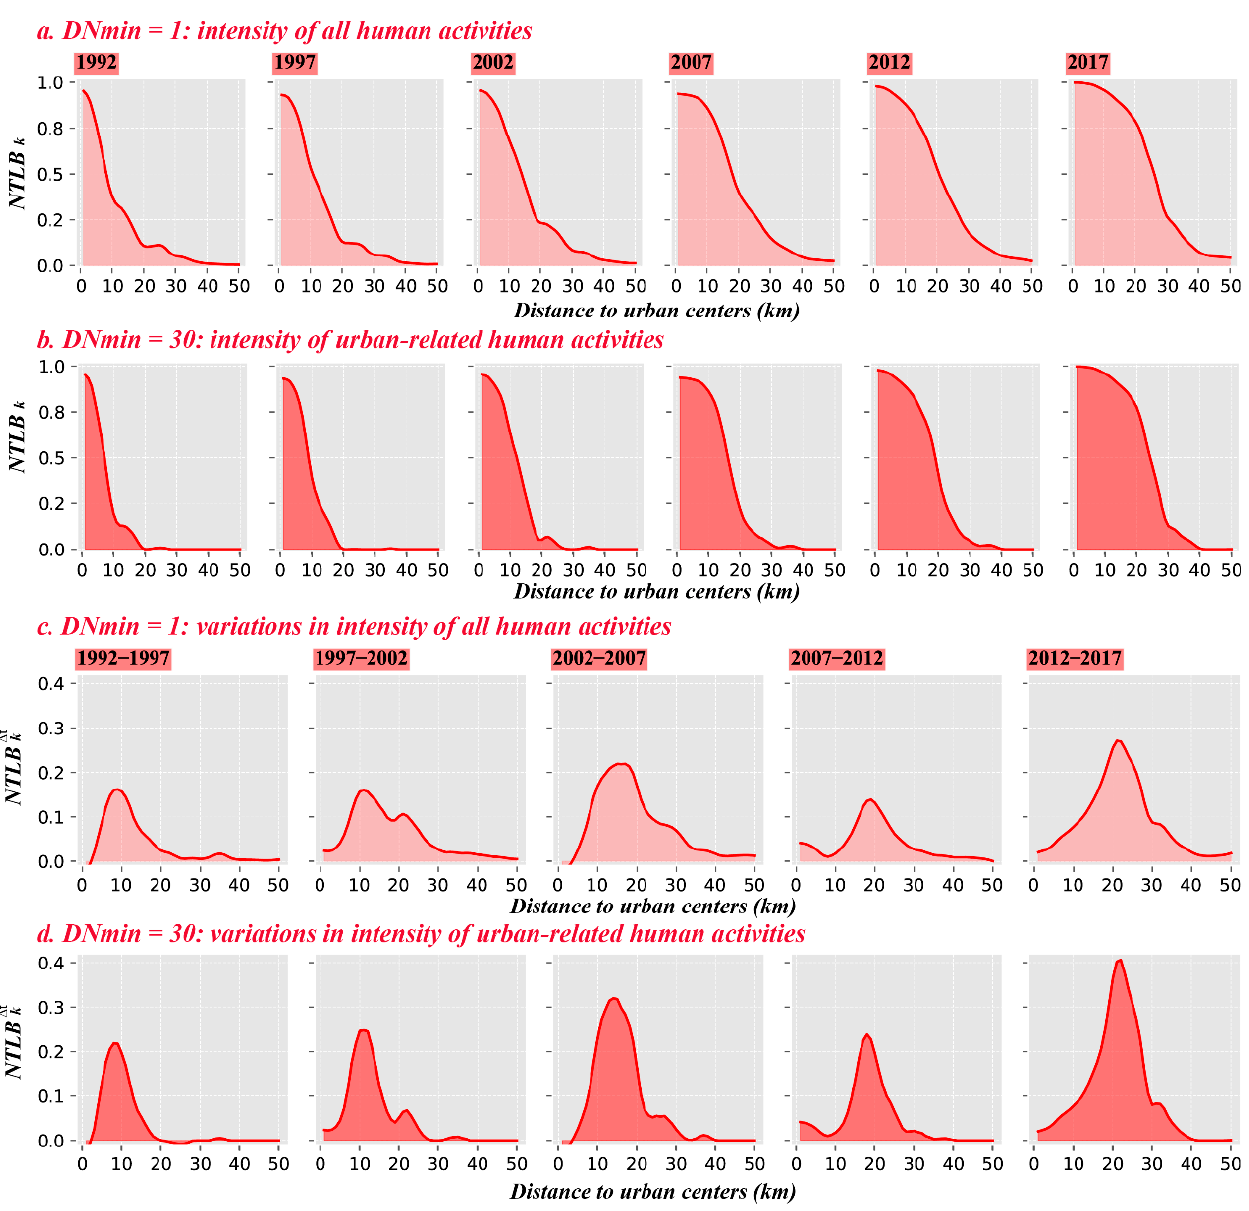
Figure 5. Intensity of human activity within concentric rings of a representative city, Wuhan, when the lower limit of DN value to extract human activities is set to 1 and 30 (the interval of time is 5 years, i.e., ∆ t = 5 ) .